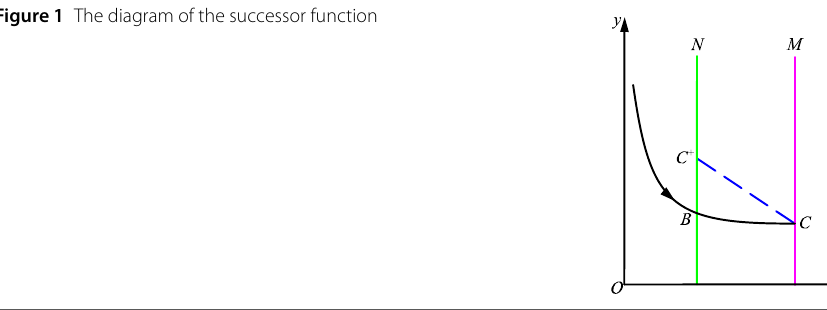
Figure 1 The diagram of the successor